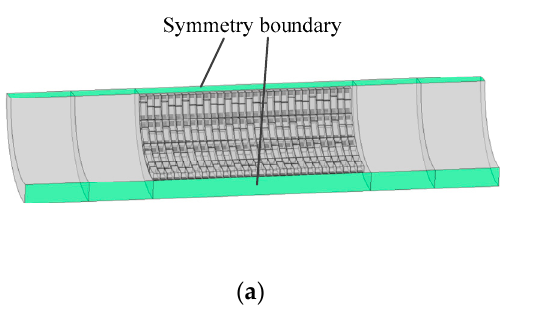
Figure 22. The geometric and detailed FE models of the ADCAA system with grazing flow (suitable for the FNSE method). ( a ) Geometric model and ( b ) FE model.